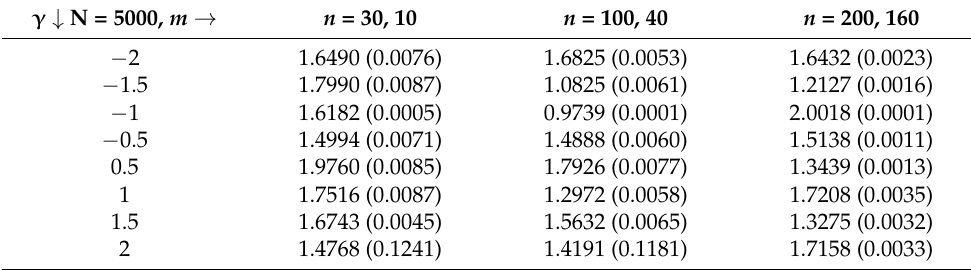
Table 7. Bayesian estimators and PR (in brackets) under GQ loss function.